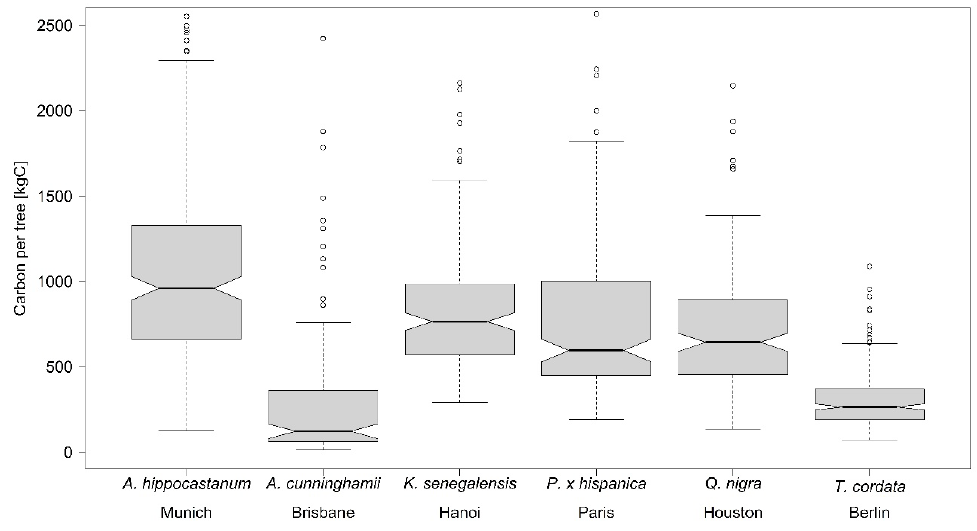
Figure 4. Carbon storage capacity of the investigated tree species in urban areas (cities), based on the 316 measured data for diameter and tree height. 317